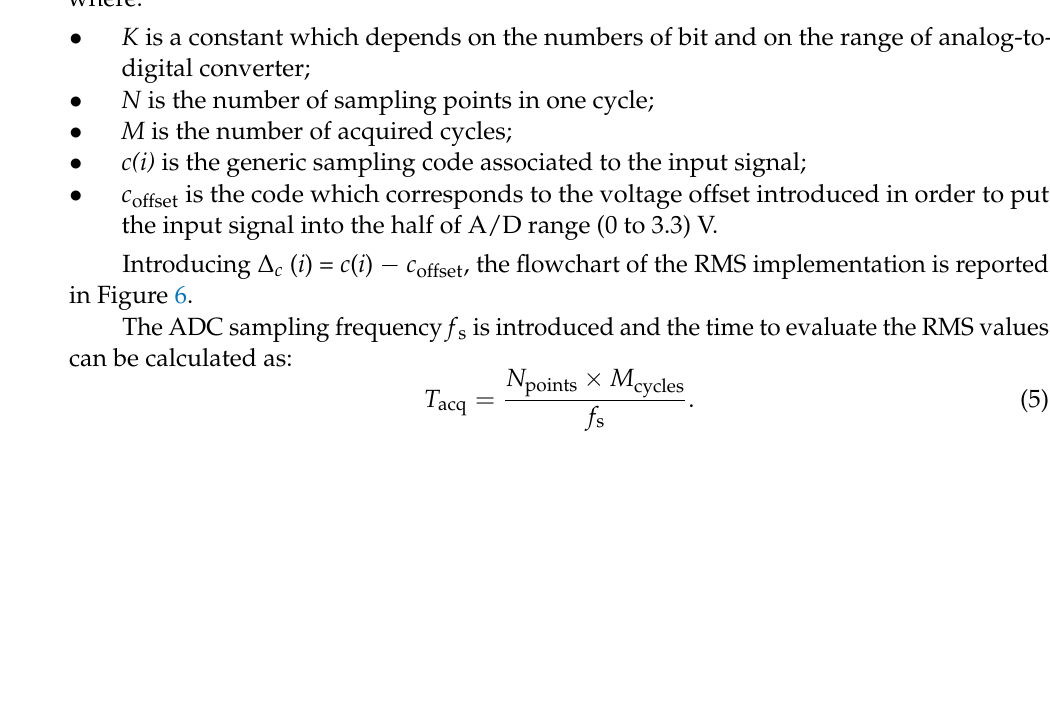
Figure 5. The developed board.